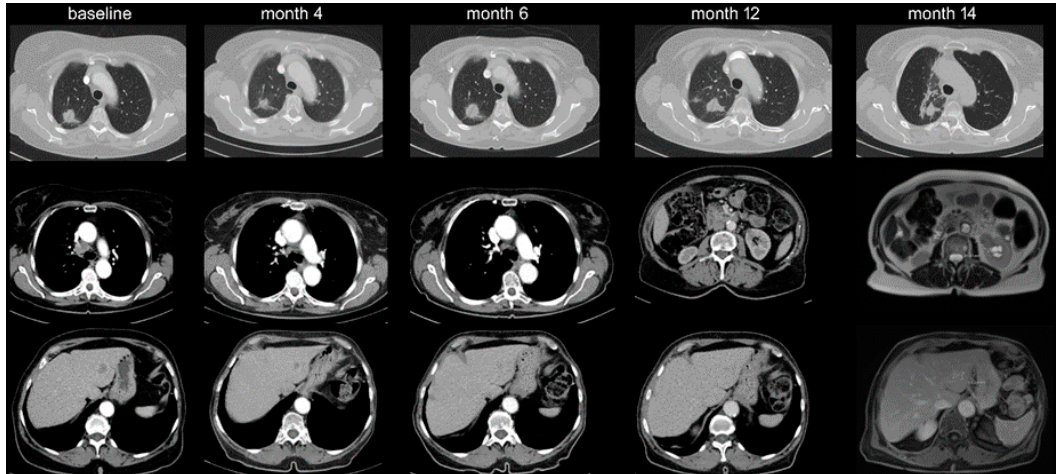
Figure 3. Lung oligoprogression and transitional cell carcinoma of the kidney. A 75-year-old female with adeno-NSCLC (PD-L1 90%) was started on pembrolizumab in September 2017 with response of the primary tumor, mediastinal lymph nodes, and liver metastases. Upon oligoprogression of the primary tumor in March 2018, thoracic radiotherapy was administered. In August 2018, a new kidney lesion was noted that grew oligoprogressive-like. At biopsy, this lesion turned out to be a transitional-cell carcinoma.